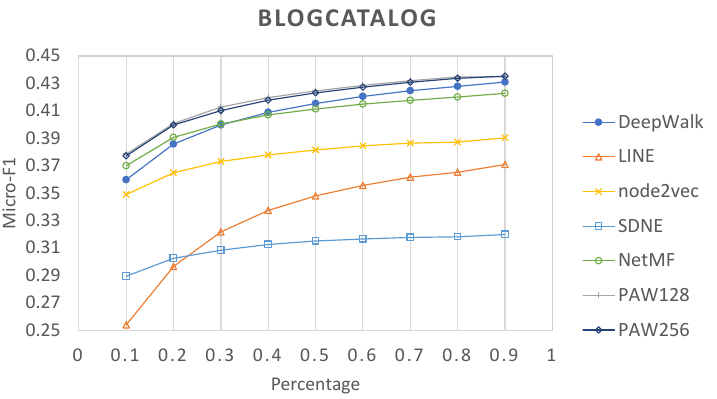
Figure 3. Micro-F1 of multi-label classification on the BlogCatalog dataset on varying the proportion of training data.